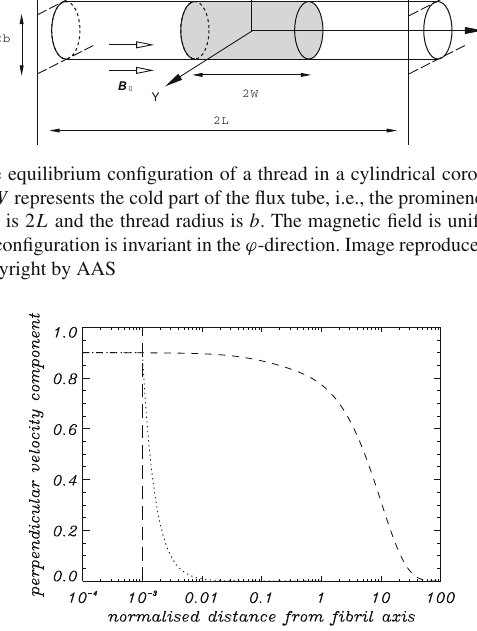
Fig. 57 Cut of the normal velocity component in Cartesian geometry (dashed line, i.e., curve of Fig. 51b) and the radial velocity component in cylindrical geometry (dotted line) in the direction across the thread axis. These solutions correspond to the (fundamental) kink mode in a prominence thread with the parameter values used in Fig. 52. The vertical long dashed line marks the thread boundary. Image reproduced with permission from Díaz et al. (2002), copyright by